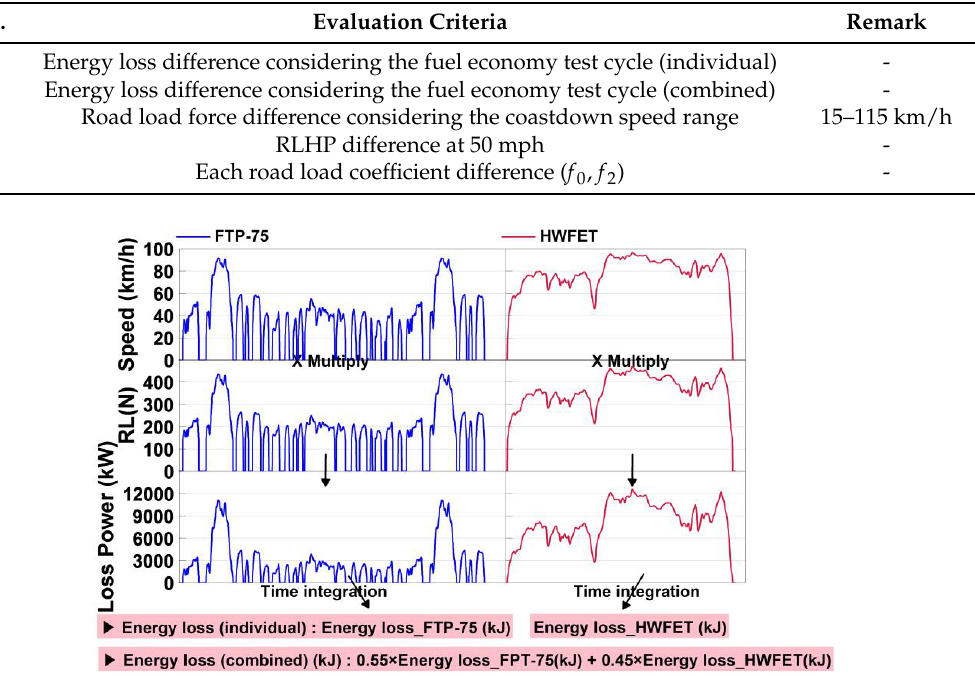
Figure 1. Calculation procedure of energy loss.